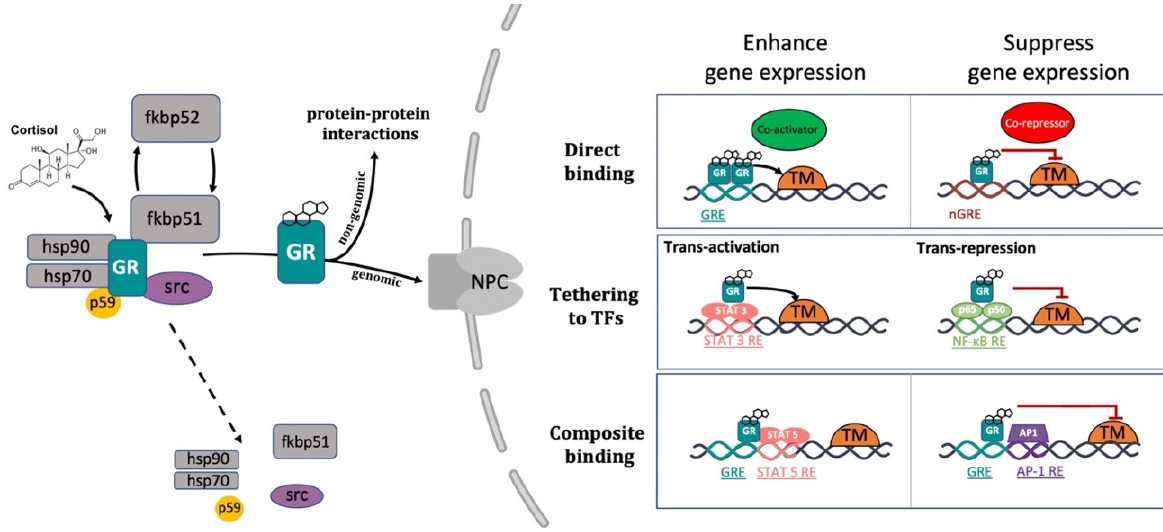
Figure 2. Representative picture of the canonical GR signalling pathway. After binding to GC, GR undergoes a FKBP51- FKBP52 mediated conformational change, becomes hyper-phosphorylated, dissociates from accessory proteins (chaperone complex) and finally translocates into the nucleus. Here, after dimerization with other GRs, it regulates the transcription of target genes by binding to DNA. Interestingly, GR may enhance or repress transcription of target genes by directly binding to palindromic GC response elements (GRE), or by tethering itself to other transcription factors apart from DNA binding, or in a composite manner by both directly binding GRE and interacting with transcription factors bound to neighbouring sites. Created with BioRender.com.